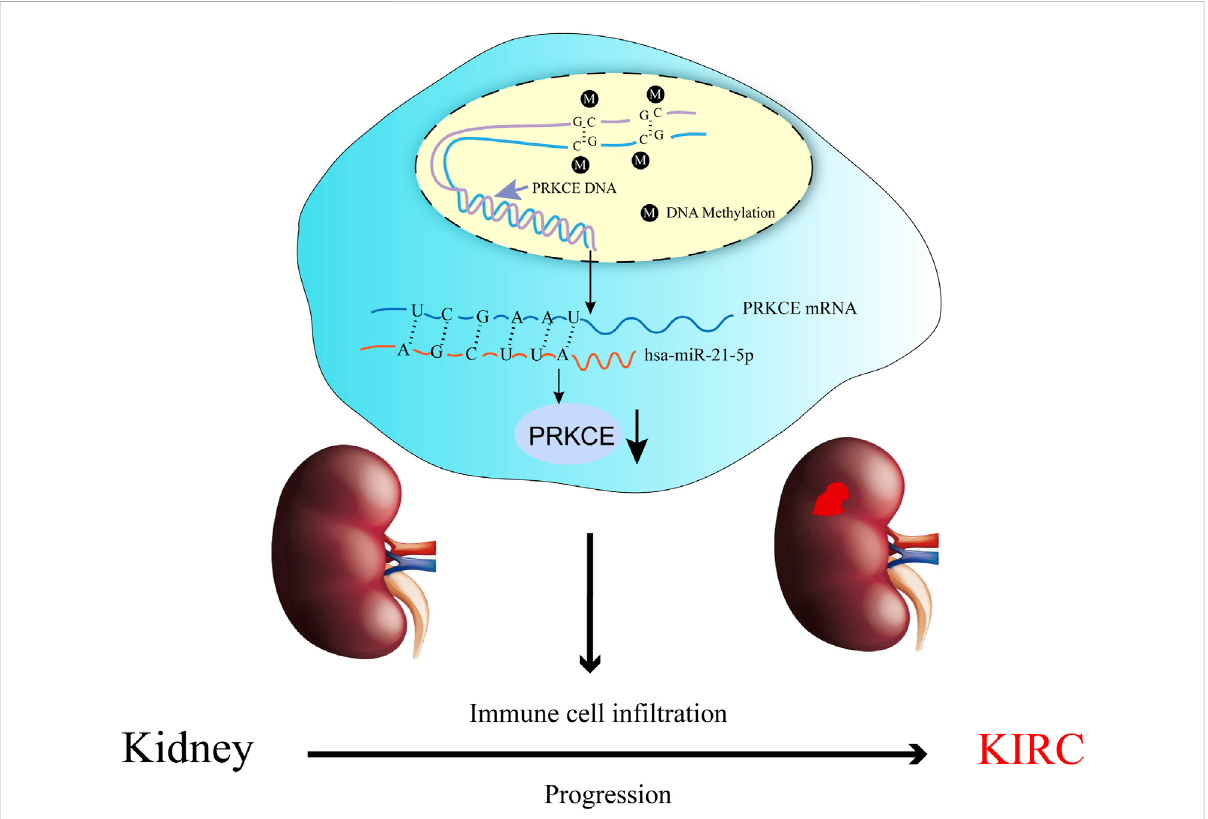
FIGURE 9 The model of hypermethylation and hsa-miR-21-5p – mediated downregulation of PRKCE in carcinogenesis of